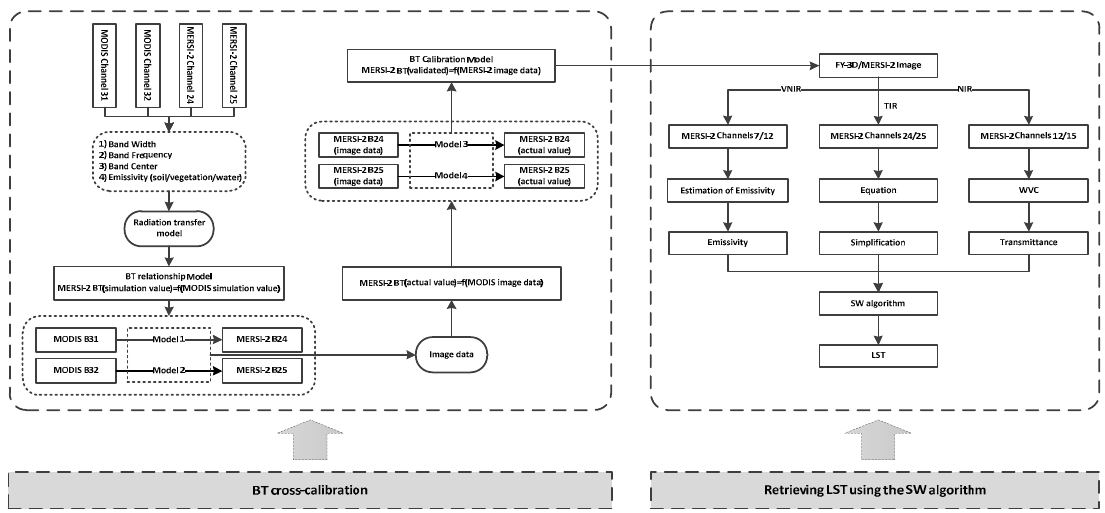
Figure 2. The technical route is divided into two parts: brightness temperature (BT) cross-calibration and retrieving LST using the split window (SW) algorithm.